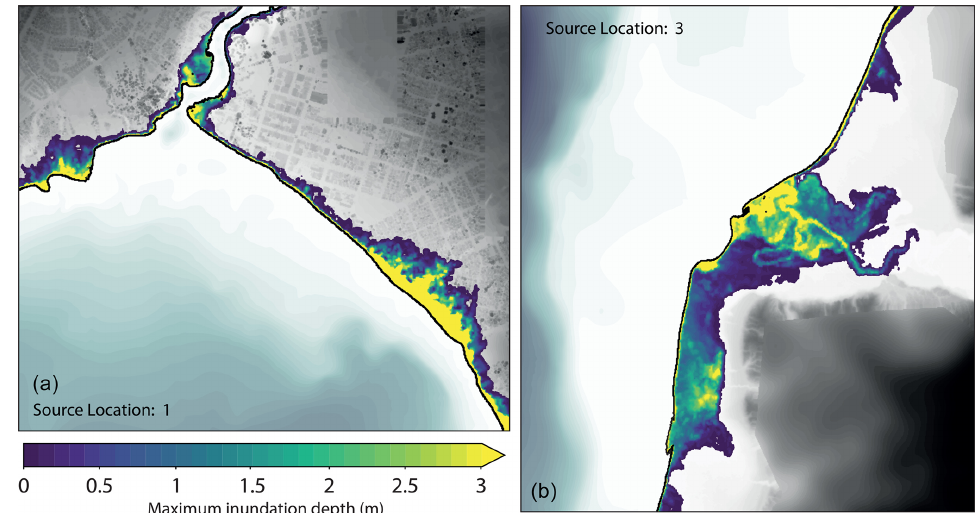
Figure 9. Map of maximum inundation heights at Taup¯o (a) and Hatepe (b) for largest size and closest source, overlaying shaded DTM detail.